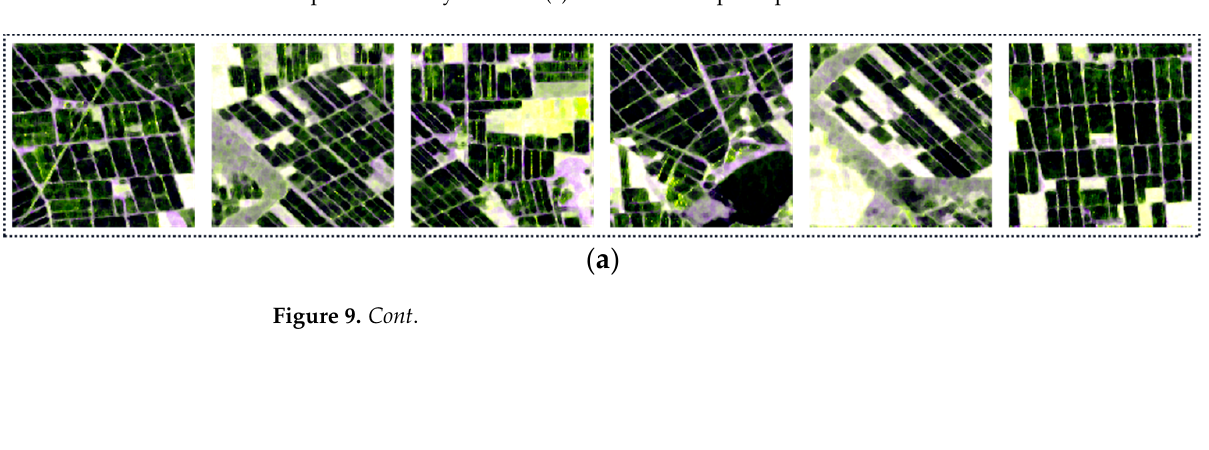
Figure 8. The PolSAR dataset form. ( a ) The single-temporal polarimetric dataset. ( b ) The multi-temporal intensity dataset. ( c ) The multi-temporal polarimetric dataset.